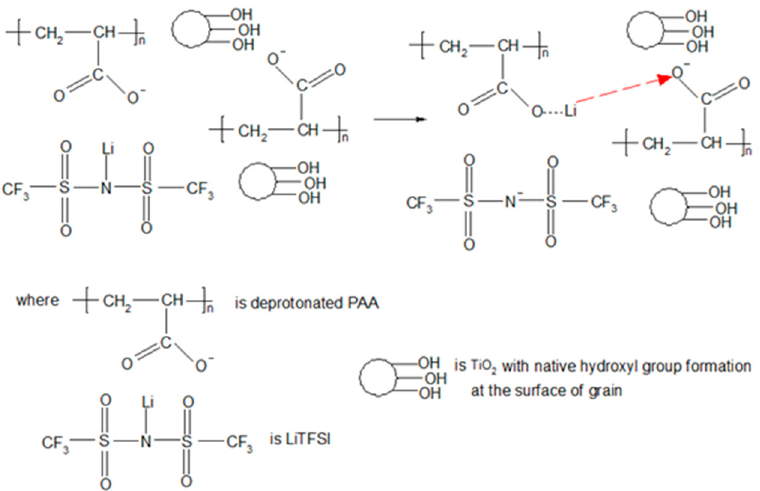
8 of 16 Figure 7. Energy density and power density of Ti 3-based EDLC over 3000 cycles of charging and discharging. 4. Discussion 4.1. Ambient Temperature-Ionic Conductivity Studies The ionic conductivity of polymer electrolyte membranes is increased by two orders of magnitude from (1.04 ± 0.01) × 10 − 6 to (8.36 ± 0.01) × 10 − 4 S·cm − 1 upon addition of 6 wt % of TiO 2 . Filler plays an important role as a solid plasticizer. The filler absorbs and retains the electrolyte solution in the polymer network. As a result, this retention raises the mobility of charge carriers which are transported from one site to another vacant site. The increase in ionic conductivity of nanocomposite polymer electrolyte membranes is also due to the formation of 3-D networks. Native hydroxyl groups will be formed on the surface of the filler particles when the fillers are dispersed in water. These 3-D networks can provide a new pathway (a space charge layer) for an ion conduction mechanism when the nanoparticles get closer to each other. Therefore, the ionic conductivity of nanocomposite